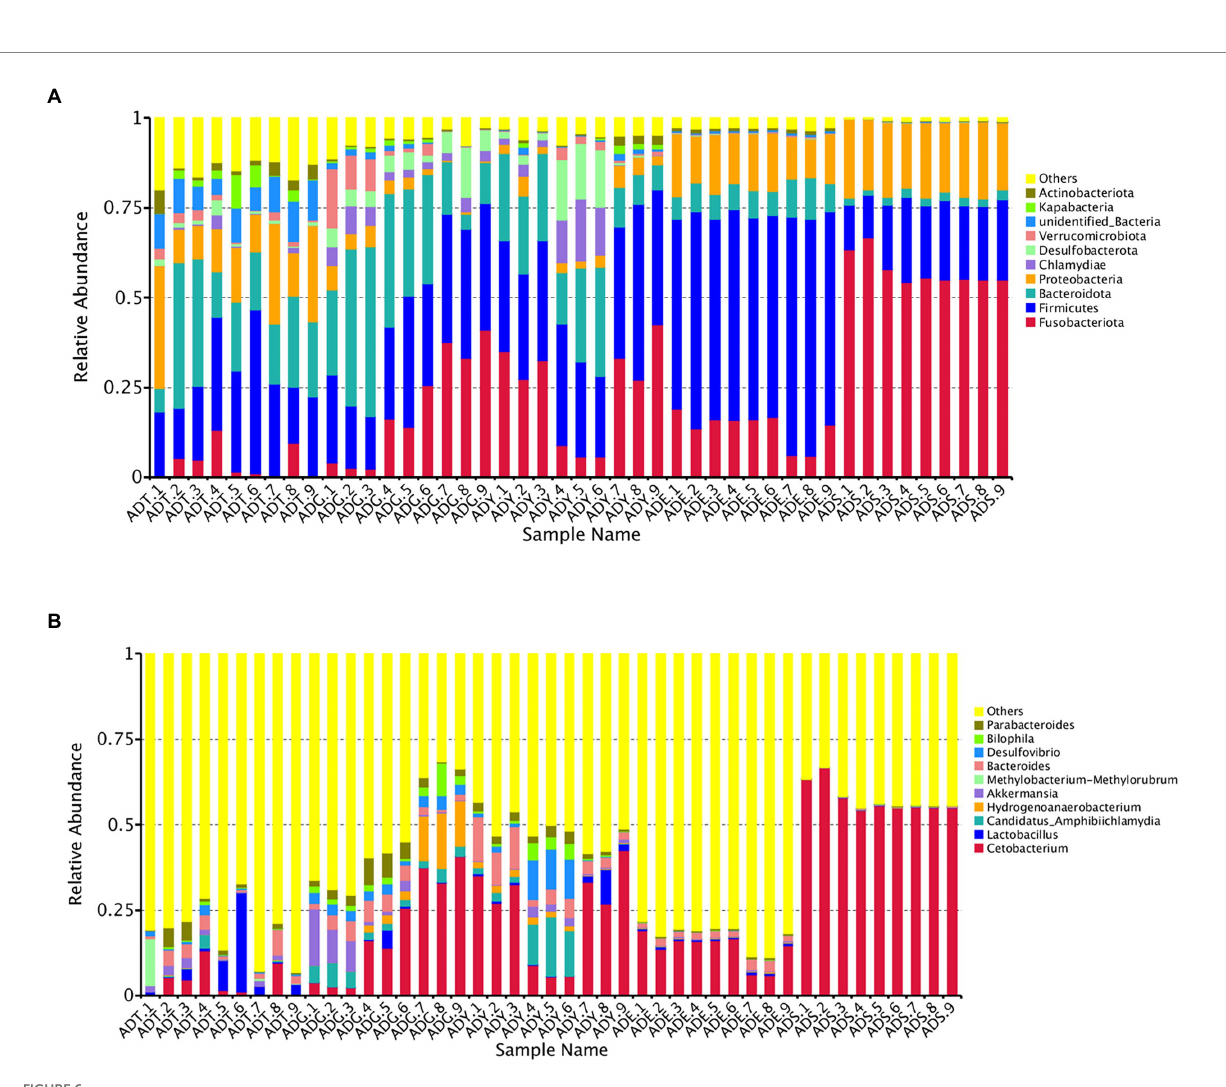
FIGURE 6 Relative abundance of the gut microbiota of A. davidianus. (A) Microbial community bar plot of phyla. (B) Microbial community bar plot of